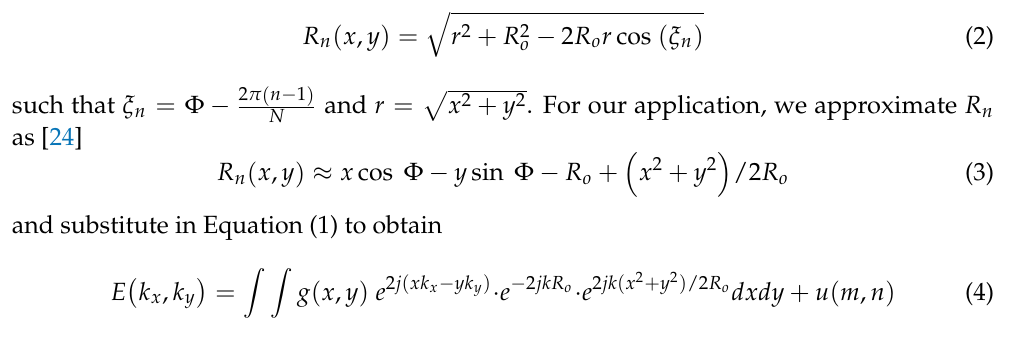
Figure 2. Geometry of an N-element uniform circular array with radius R o . The point scatterer ( x , y ) is at a distance r from the phase center of the geometry. For a uniform circular array of radius 𝑅